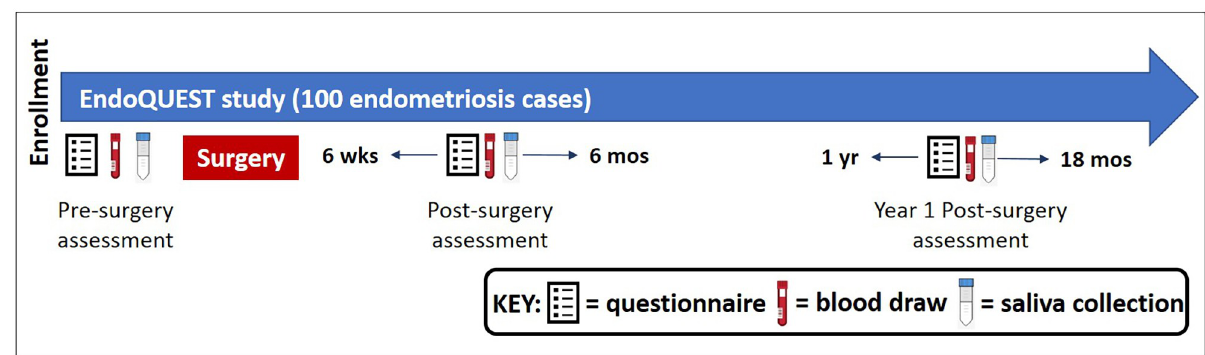
Fig 1. Schematic of the EndoQUEST questionnaire and biospecimen